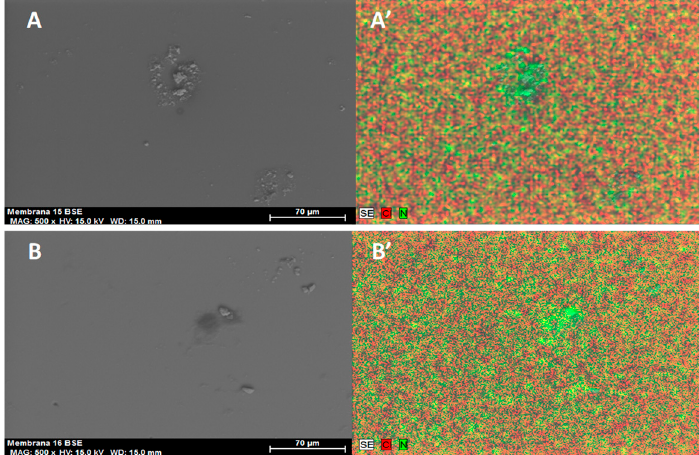
Figure 3. SEM and elemental mapping of membranes containing 70% w / w of IL ( A , A’ ) and membranes containing 30% w / w of IL ( B , B’ ) before being used.